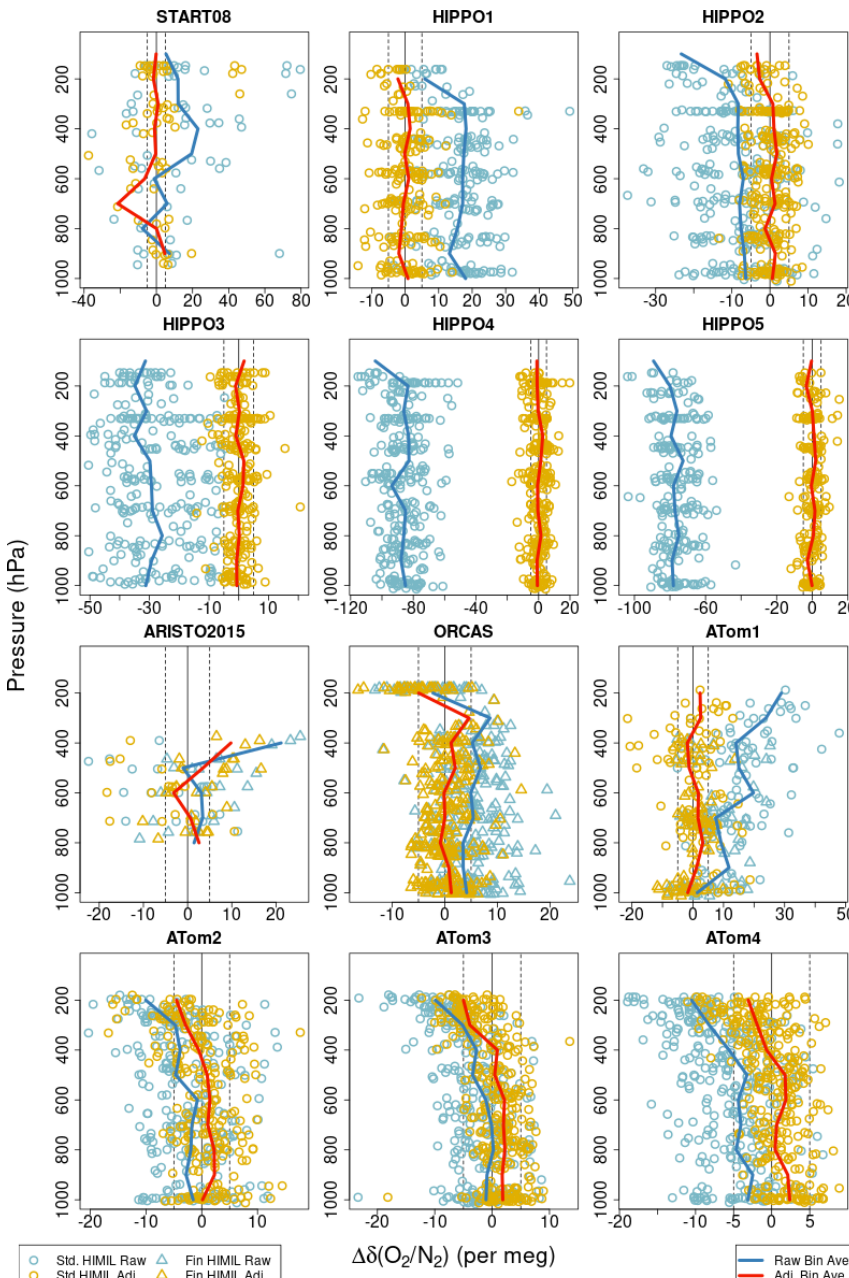
Figure 8. AO2 δ (O 2 / N 2 ) minus Medusa δ (O 2 / N 2 ) ∗ differences for each campaign plotted versus pressure. Symbol shapes distinguish the different AO2 inlet types. Blue symbols show differences between raw unadjusted AO2 δ (O 2 / N 2 ) measurements and corrected δ (O 2 / N 2 ) ∗ Medusa measurements. Here, by “raw unadjusted” we mean after ascent-minus-descent adjustment but before any Medusa-based adjustment. Yellow symbols show differences after adjusting the AO2 measurements to match Medusa δ (O 2 / N 2 ) ∗ by a linear time-of-flight trend plus mean offset for each flight or, in the case of the second half of ATom-1, by a linear pressure trend plus mean offset for each flight. The blue and yellow symbols here correspond to the values reported in rows 6 and 9, respectively, of Table S3 in the Supplement. Blue lines show the differences using unadjusted AO2 δ (O 2 / N 2 ) averaged by 100hPa bins. Red lines show binned averages using adjusted AO2 δ (O 2 / N 2 ).